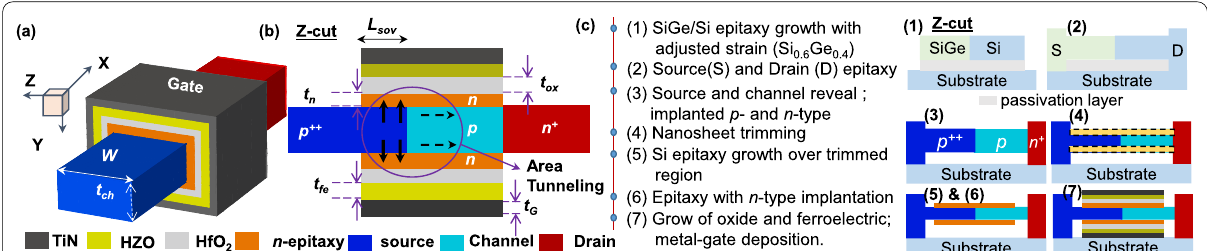
Fig. 2 a The proposed structure of GAA nanosheet FATFET and b its 2D view along the Z-cut, showing device specifications, regions, and location of area tunneling. An n -epitaxial region surrounds the overlapped source ( L sov ) and channel regions to achieve complete area of tunneling. c The simplified processing mechanisms for the proposed geometry based on recent